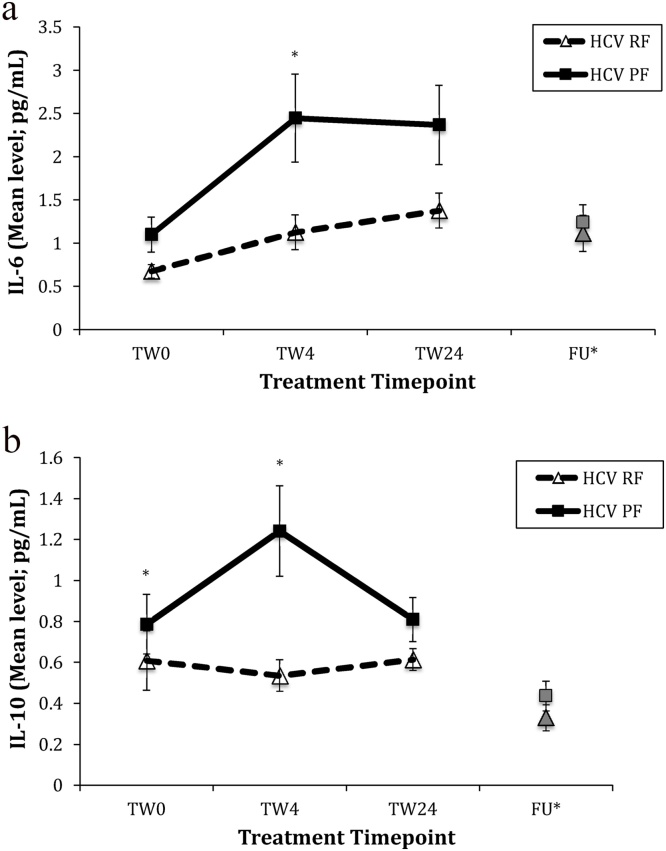
(a): Changes in IL-6 in HCV RF vs. PF groups. (RF n = 20; PF n = 12) and (b) Changes in IL-10 in HCV RF vs. PF groups. (RF n = 18; PF n = 12). * Mann Whitney U test p < 0.05; FU* - not included in ANOVA, included for illustrative purposes only; HCV – Hepatitis C Viral infection, TW – Treatment Week, IL – Interleukin.